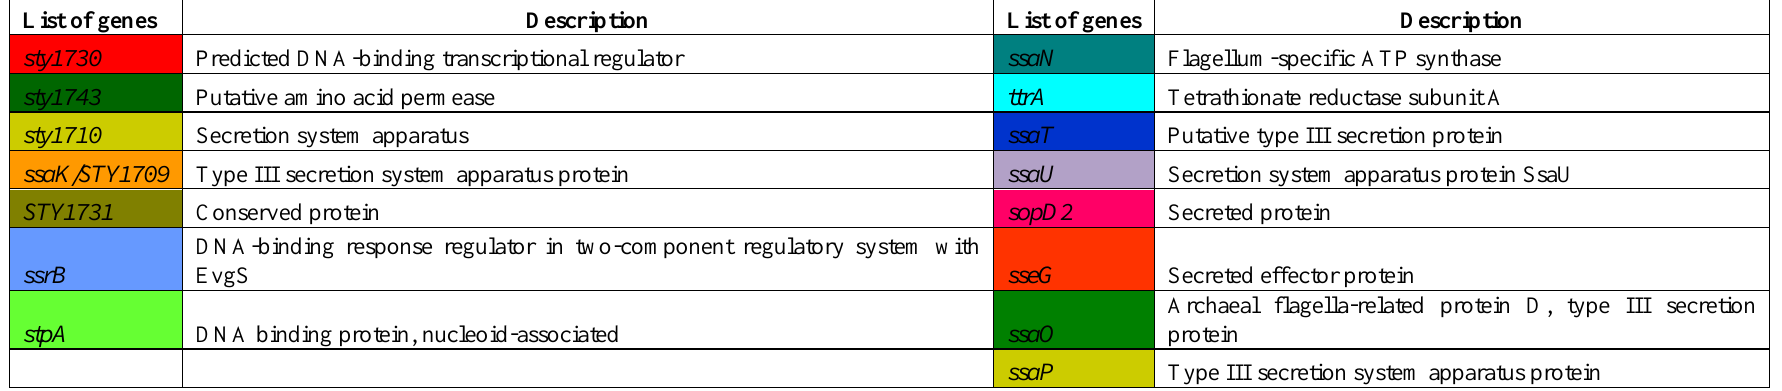
Table 7: Description for the genes in Figure 12a. The colour of gene corresponds to the colour of the line in the gene expression graph in SPI-2. List of genes